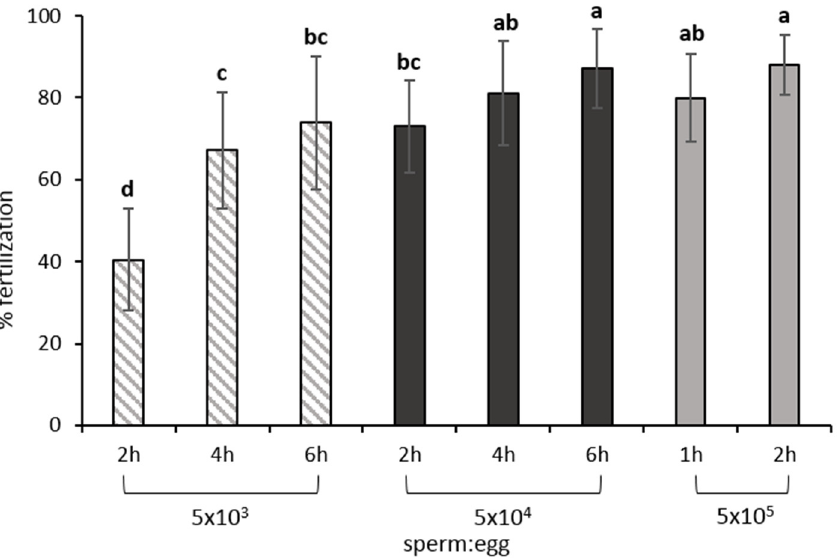
Figure 8. Percentage of fertilized eggs in spotted wolfish relative to the contact time and the sperm to egg ratio used. Bars with stripes for 5 × 10 3 sperm per egg, dark gray bars for 5 × 10 4 sperm per egg and light gray bars for 5 × 10 5 sperm per egg. Different letters stand for significant differences detected with Duncan’s multiple comparison test ( p < 0.05). The error bars represent the standard error of the mean ( n = 4). Adapted from Beirão and Ottensen [26].